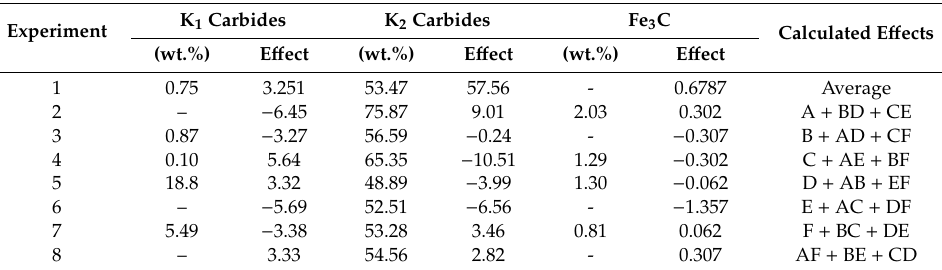
Figure 4. Superimposed diffractograms obtained in the eight experiments.